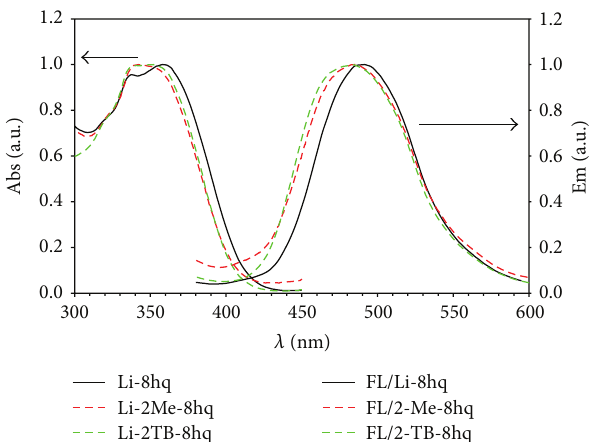
Figure 2: Absorption and fluorescence spectra of Li-8-hq, Li-2Me- 8hq and